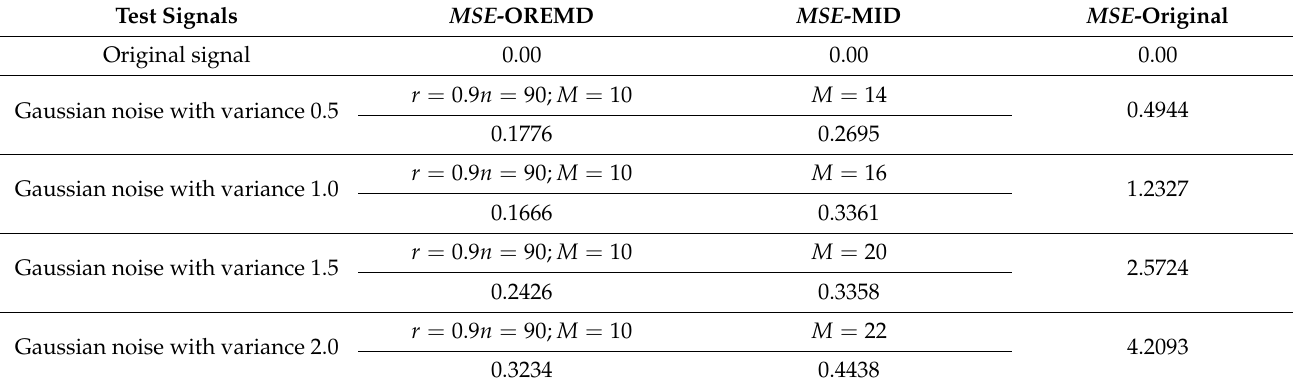
Table 5. Sifting effect of different signal